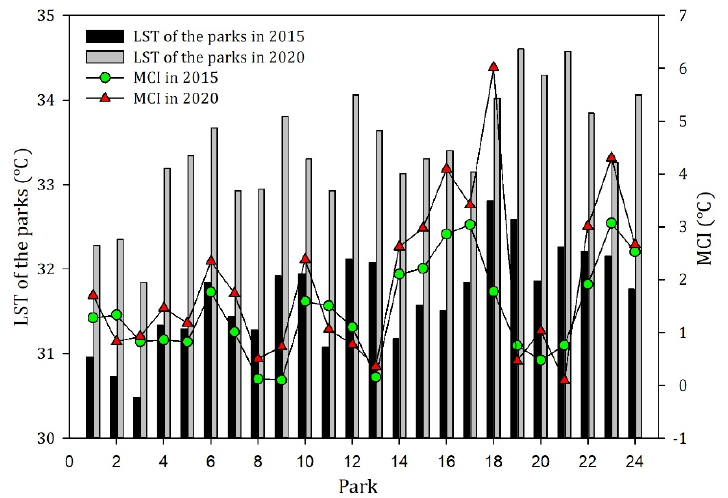
Figure 4. The LST inside the 24 parks and their MCIs in 2015 and